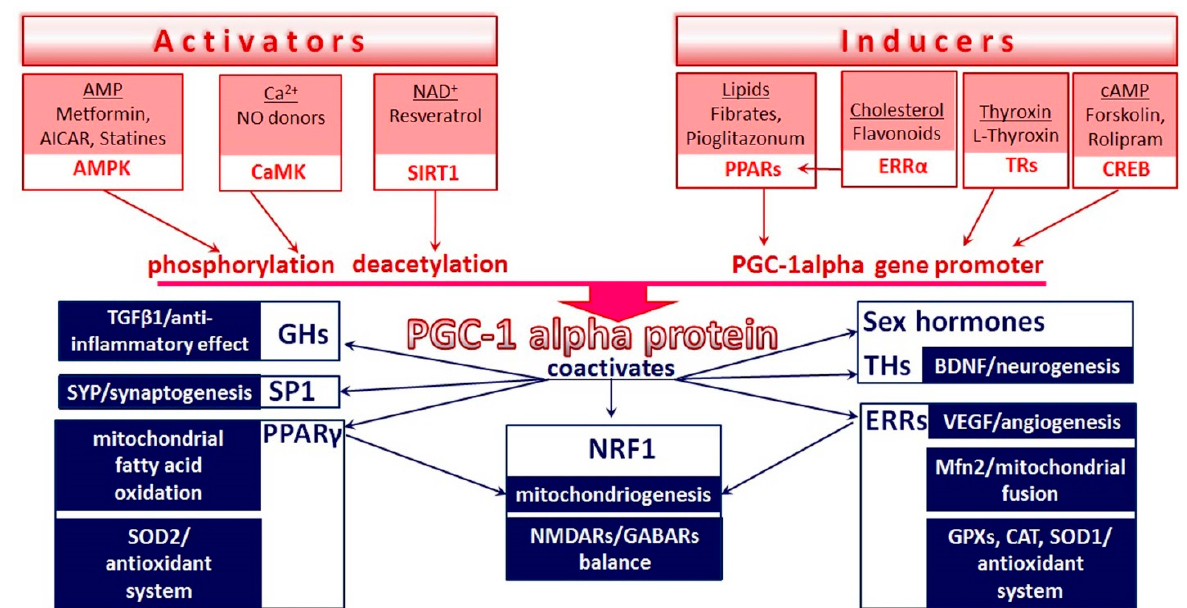
Figure 1. Mechanisms of positive regulation of PGC-1 α by physiological/pharmacological modulators and basic PGC-1 α - dependent molecular targets that determine neuroprotective effects. All arrows represent positive regulation (see expla- nations in text). Abbreviations: AICAR: 5-Aminoimidazole-4-carboxamide ribonucleotide; AMP: Adenosine monophos- phate; AMPK: Adenosine monophosphate-activated protein kinase; BDNF: Brain-derived neurotrophic factor; CaMK: Ca 2+ /calmodulin-dependent protein kinase; cAMP: Cyclic adenosine monophosphate; CAT: Catalase; CREB: cAMP- responsive element-binding protein; ERRs: Estrogen-related receptors; GABARs: Gamma aminobutyric acid receptors; GHs: Glucocorticoid hormones; GPXs: Glutathione peroxidases; Mfn: Mitofusin; NAD: Nicotinamide adenine dinucleotide; NMDARs: N-methyl-D-aspartate receptors; NRF: Nuclear respiratory factor; PGC–1 α : Peroxisome proliferator-activated receptor γ coactivator 1 α ; PPARs: Peroxisome proliferator-activated receptors; SIRT: Silent information regulator two proteins (sirtuins); SOD: Superoxide dismutase; SP1: Specificity protein 1; SYP: Synaptophysin; TGF: Transforming growth factor; THs: Thyroid hormones; TRs: Thyroid hormone receptors; VEGF: Vascular endothelial growth factor.